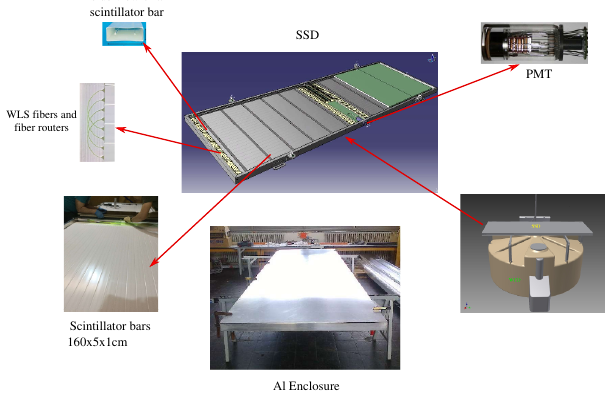
Figure 1: Layout of an SSD unit.